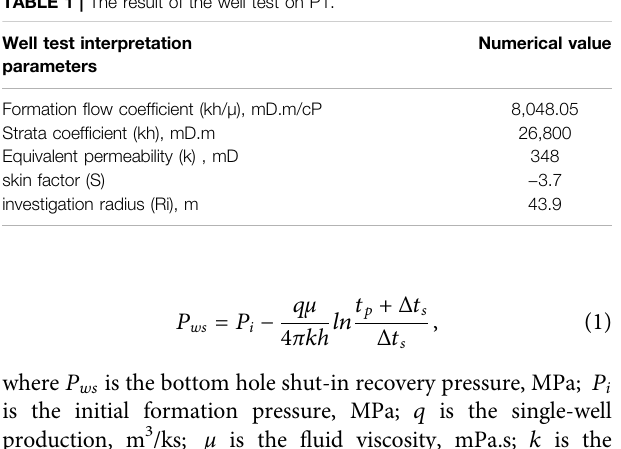
TABLE 1 | The result of the well test on